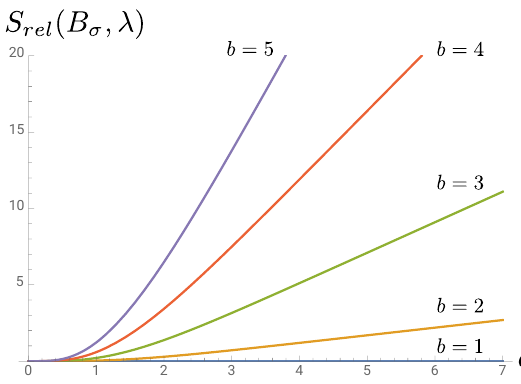
Figure 3 . The behavior of S rel ( B (cid:27) ; (cid:21) ) (2.9) w.r.t. a for b = 1 ; : : : ; 5, where a = 2 (cid:25)(cid:27)=(cid:12) 0 and b = (cid:12) 0 =(cid:12) . We set the global prefactor c= 3 = 1 and see that S rel ( B (cid:27) ; (cid:21) ) grows with a for (cid:12)xed b . In particular, this implies that S rel ( B (cid:27) ; (cid:21) ) grows with B (cid:27) , i.e. (cid:27) , for (cid:12)xed (cid:21) and (cid:21) 0 , which is in agreement with the monotonicity of the RE (1.13). For b = 1 we (cid:12)nd S rel ( B (cid:27) ; (cid:21) ) = 0, which is to be expected from (1.5), since this case corresponds to (cid:21) = (cid:21) 0